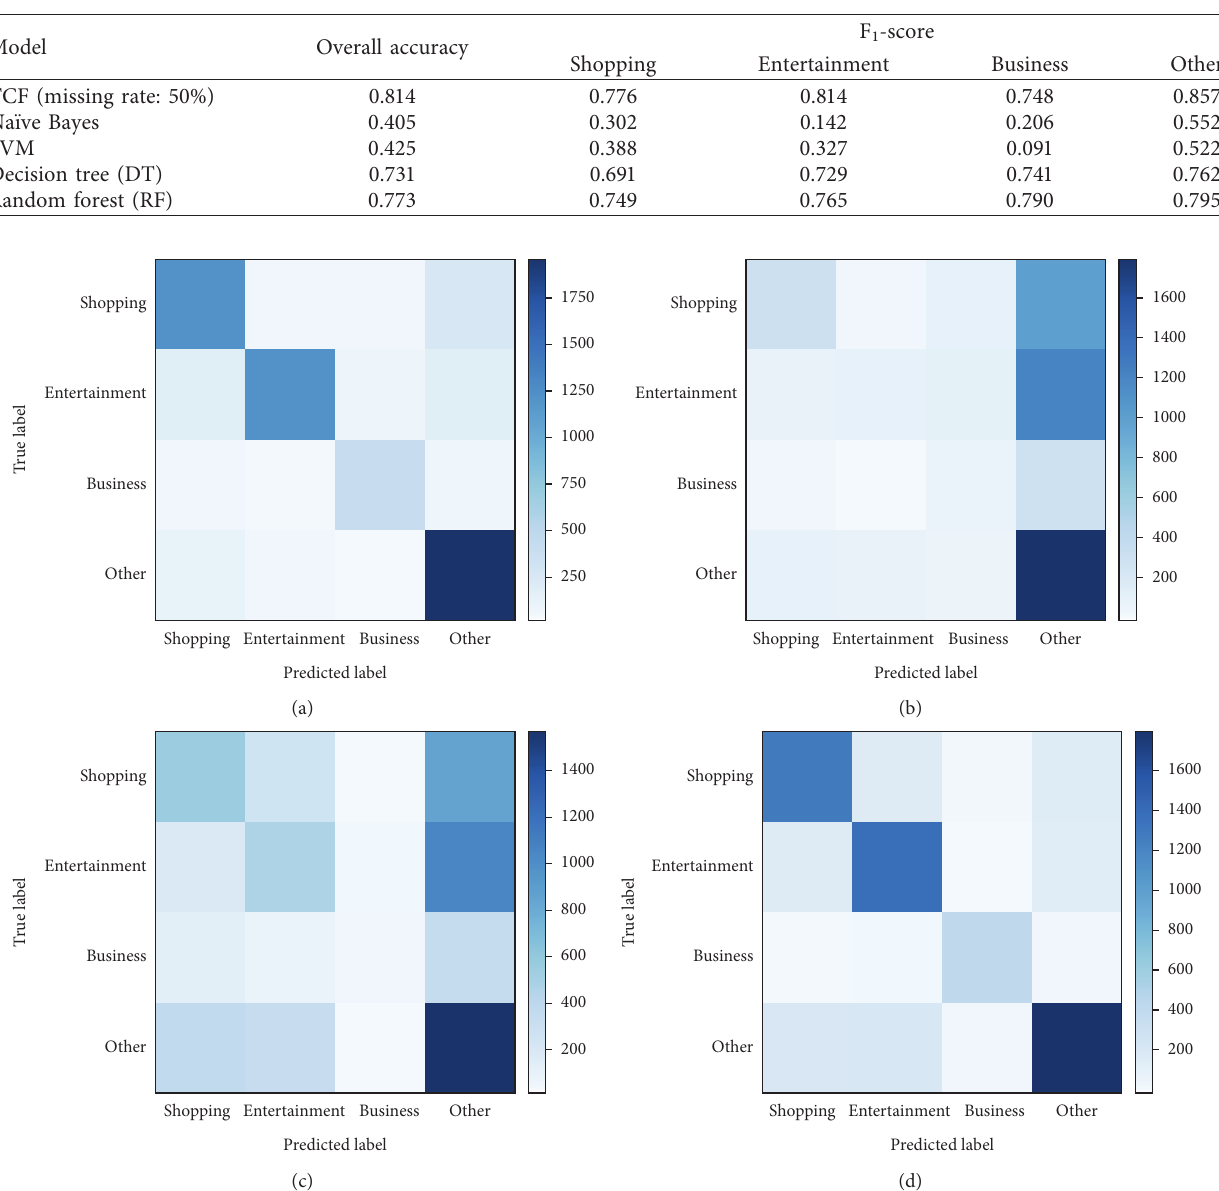
Table 3: Benchmark test result.